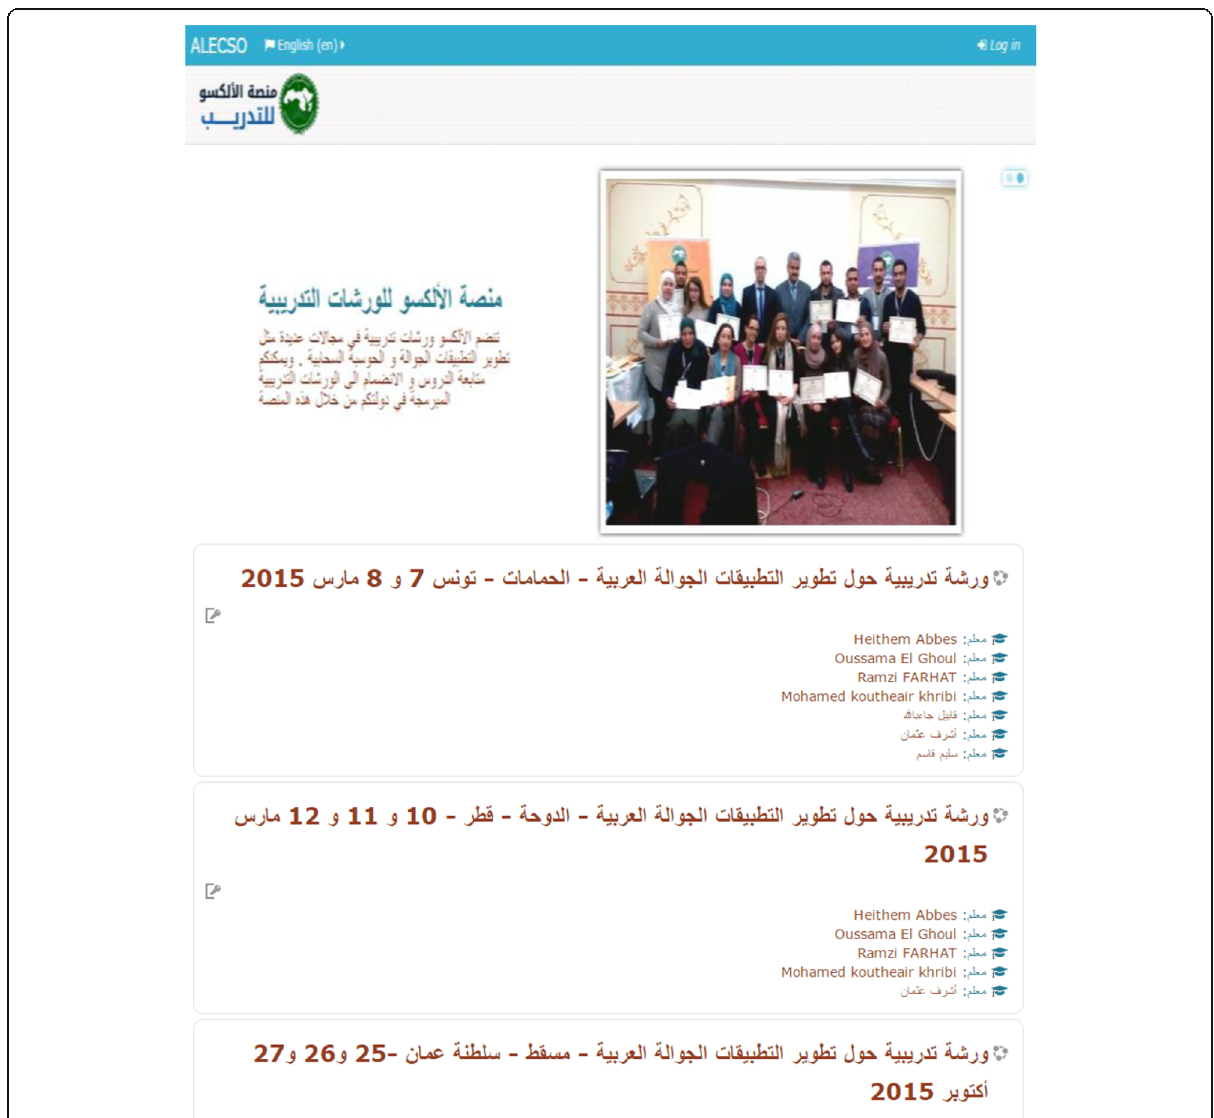
Fig. 16 ALECSO training workshops on Mobile Development available online on the ALECSO training